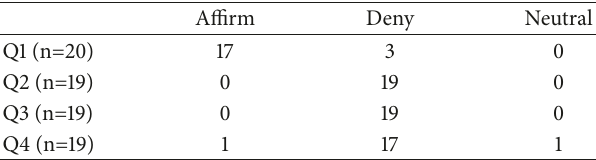
Table 2: Numbers of attitudes in each